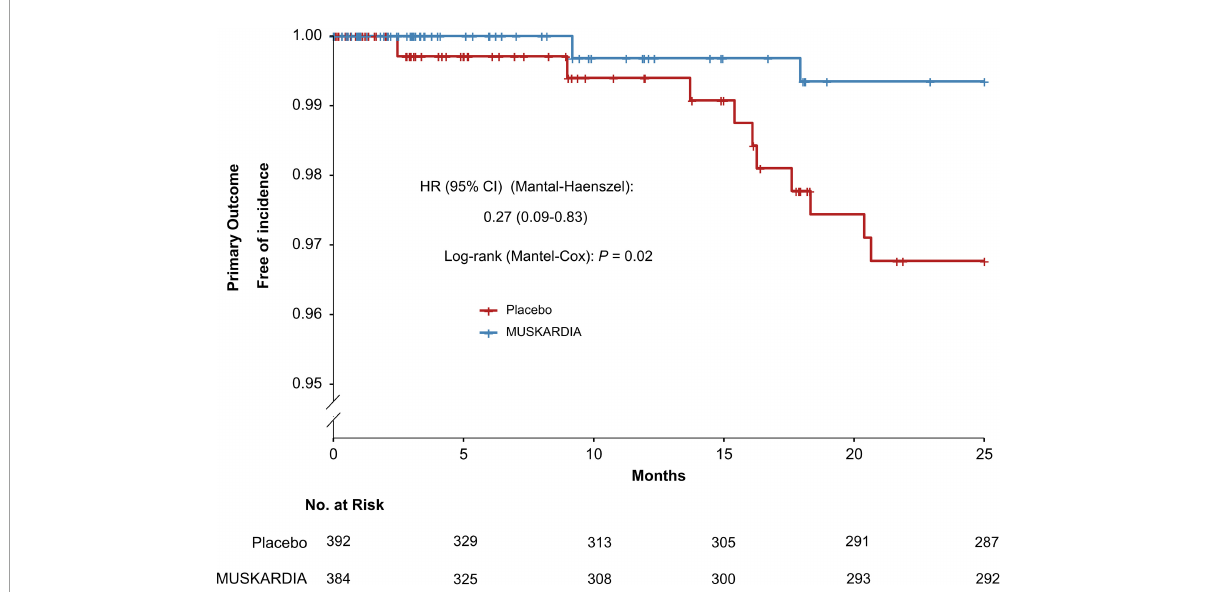
FIGURE1 Kaplan–Meier curve analysis of the primary composite outcome. Hazard ratio = 0.27 (95% confidence interval: 0.09–0.83), P = 0.02.